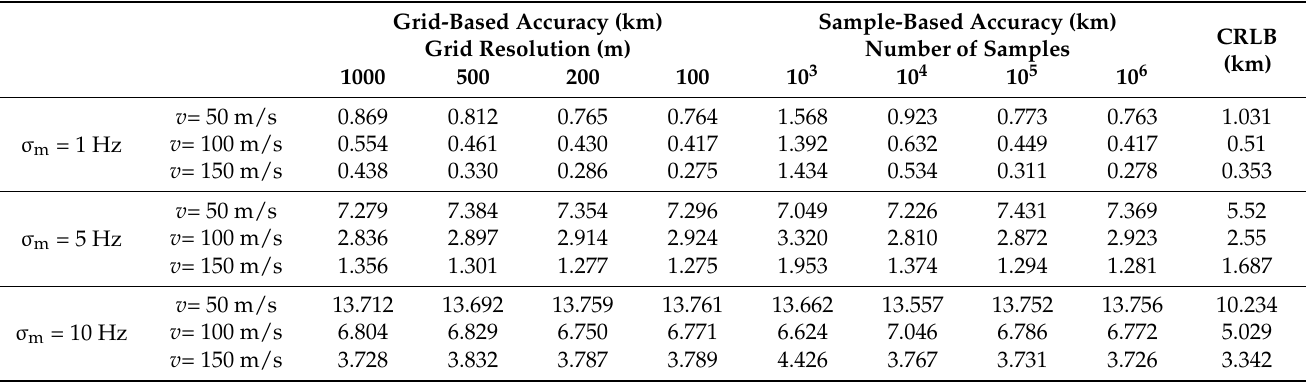
Table 1. Solution accuracies and corresponding Cram é r–Rao lower bound (CRLB) with a baseline of 20 km.